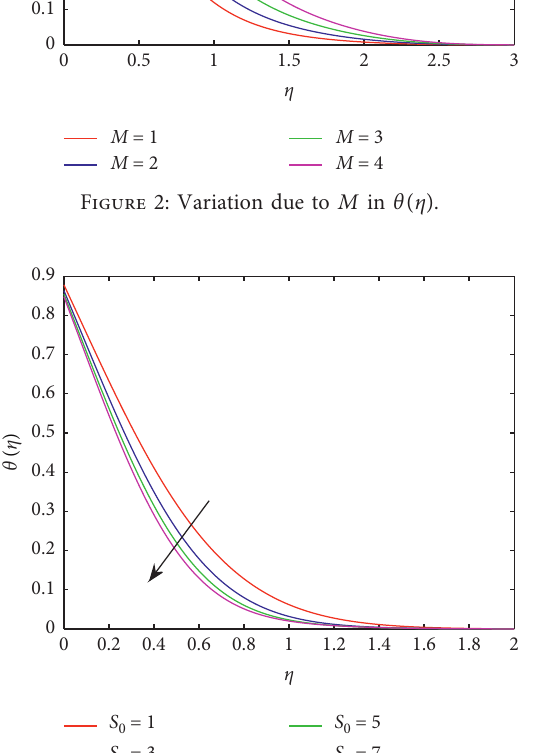
Figure 3: Variation due to S